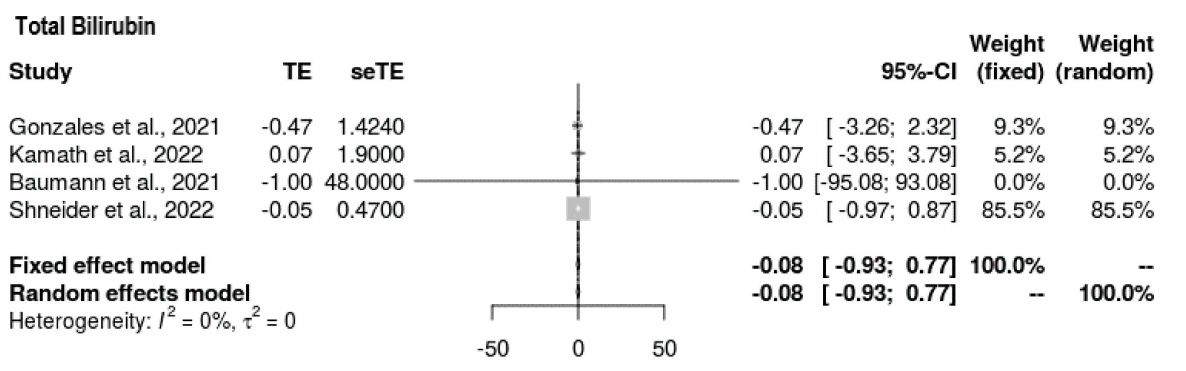
Figure 7. Forest plot depicting total bilirubin outcomes at end-line compared to baseline